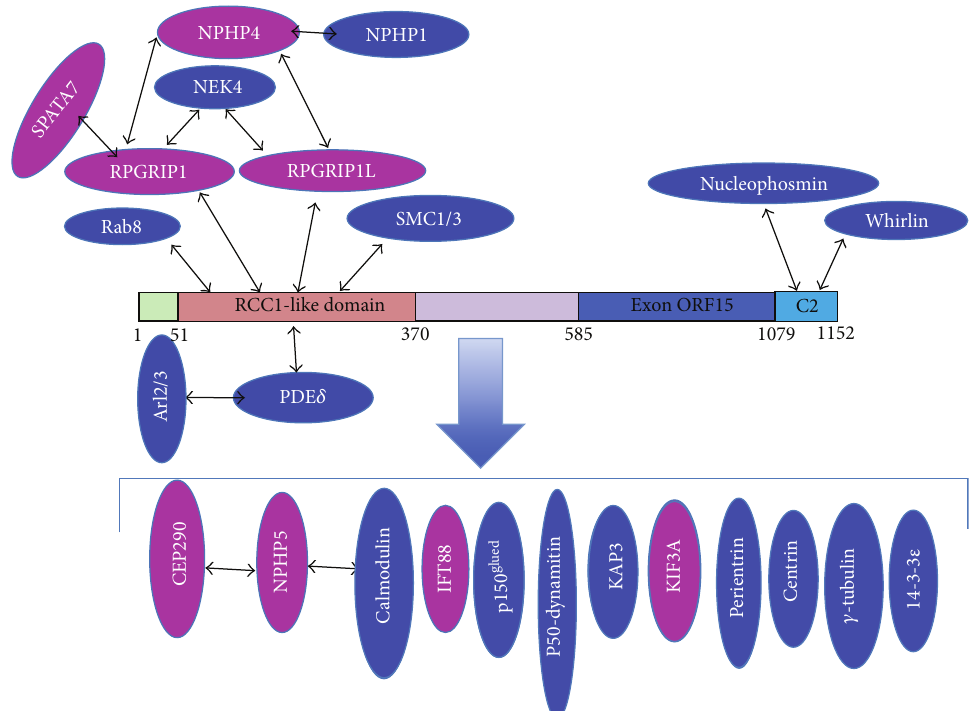
Figure 4: RPGR interacting protein network. Black arrows show direct interaction; the big blue arrow shows proteins in RPGR complex detected by coimmunoprecipitation. Proteins labelled in pink are implicated in retinal degeneration. The RCC1-like domain directly interacts with RPGRIP1, RPGRIP1L, SMC1/3, PDE 𝛿 , and Rab8. The end section of the C-terminal directly interacts with nucleophosmin and whirlin. Mutations in RPGRIP1, RPGRIP1L, CEP290, NPHP4, NPHP5, IFT88, KIF3A, and SPATA7 also cause